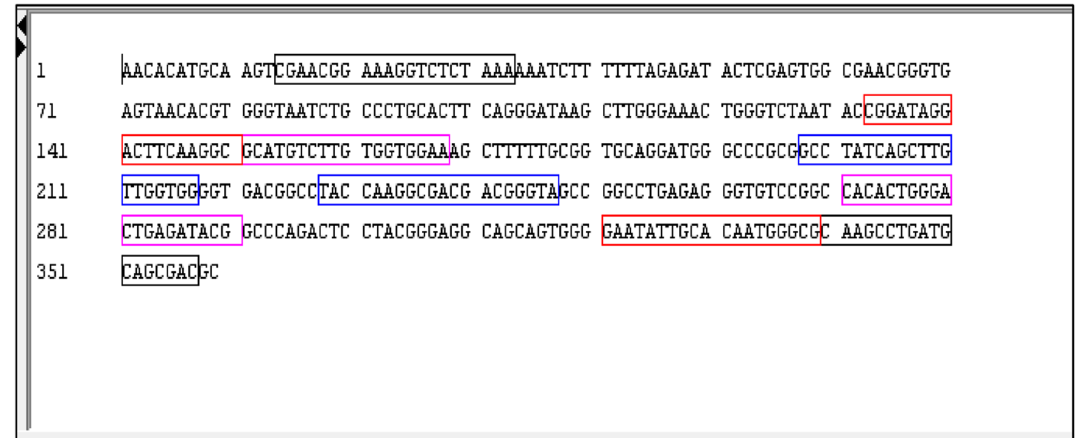
Figure 1. Location of 16S rRNA-S LAMP primers in target gene sequence.